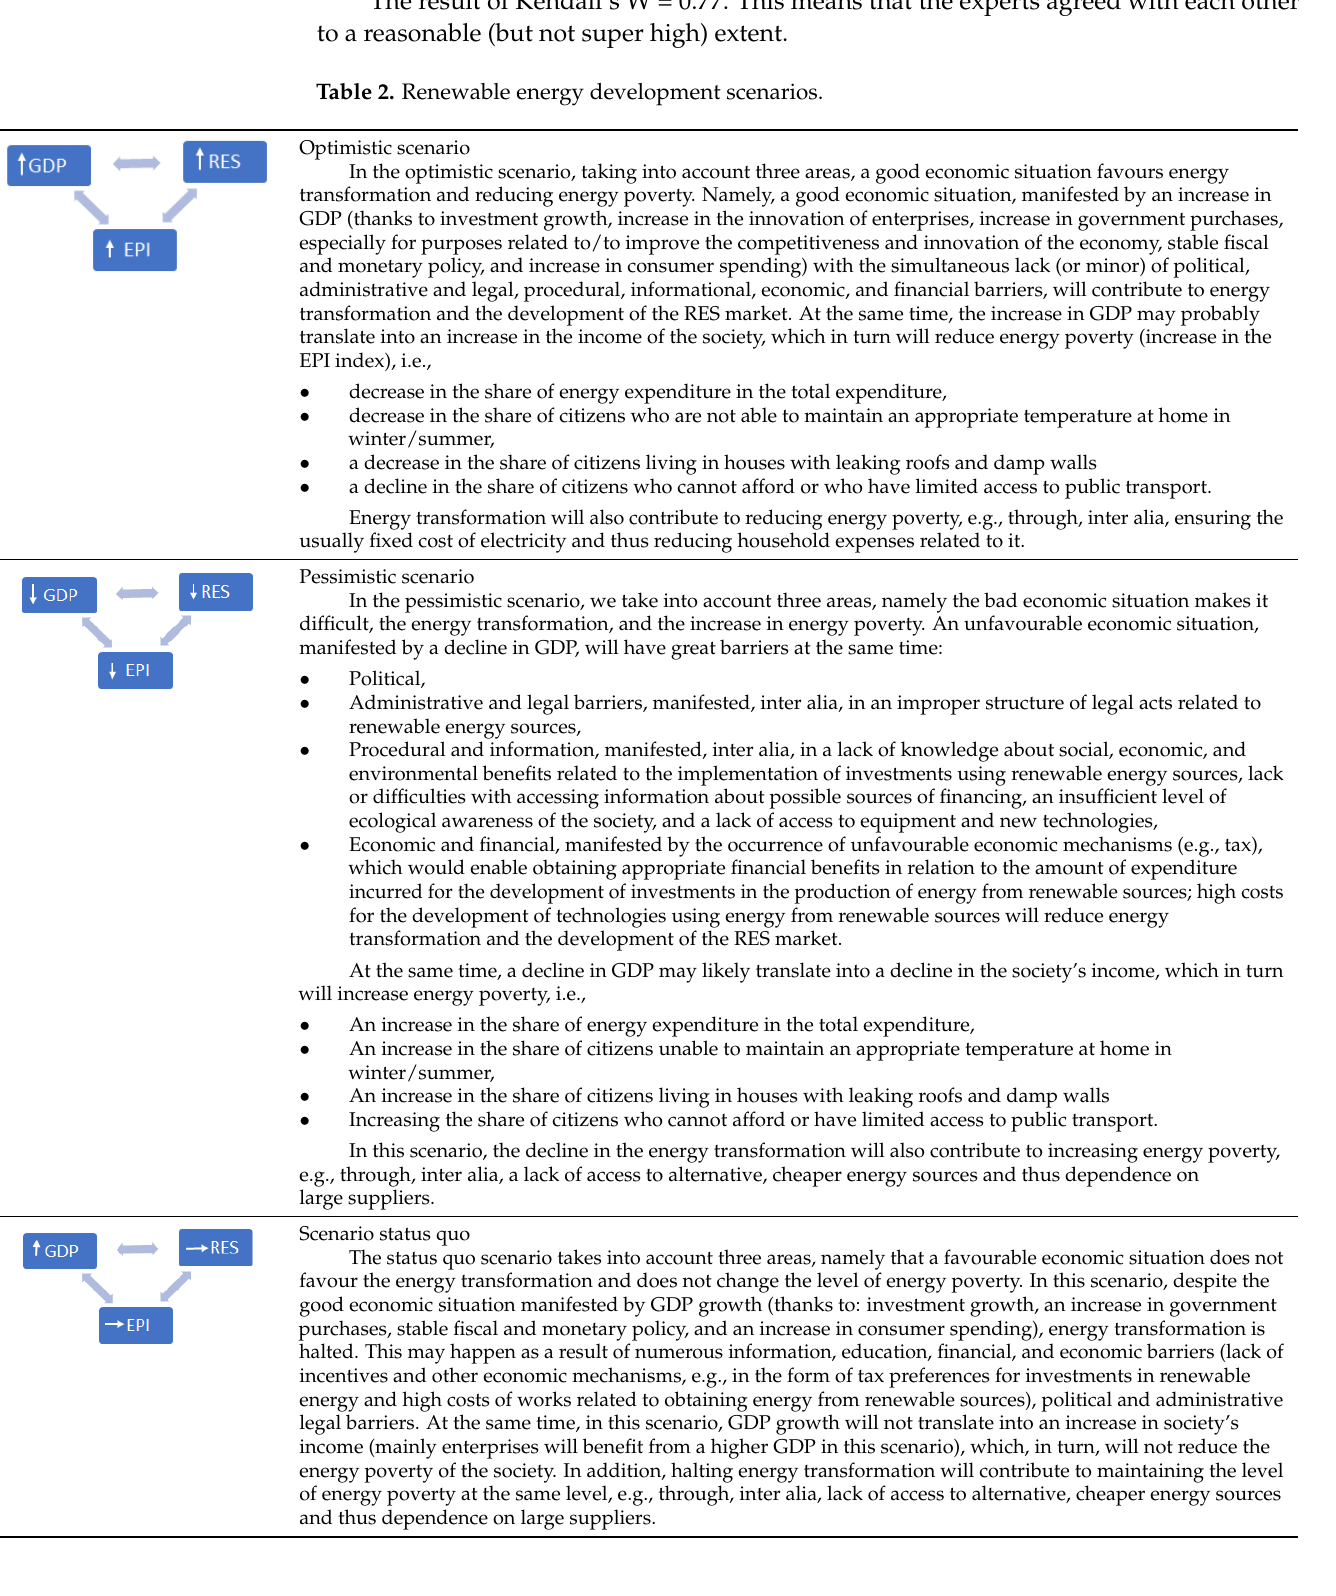
Figure 10. Scenario framework. Source: own prepared. The characteristics of the possible renewable energy development scenarios are presented in Table 2. Table 2. Renewable energy development